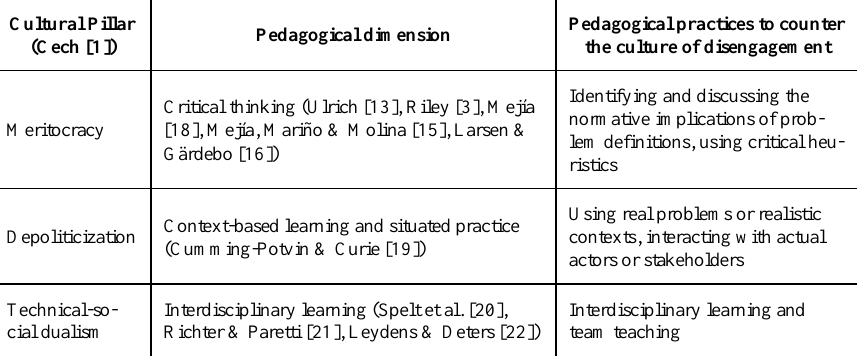
Table 4. Methodological antidotes to the pillars of a culture of